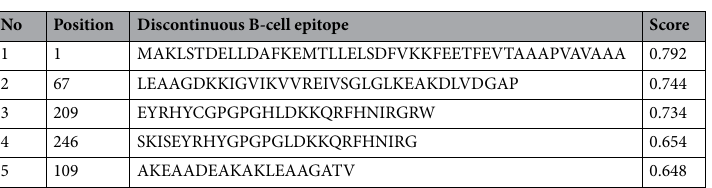
Table 5. A list of discontinuous B-cell epitopes predicted by the ElliPro server.